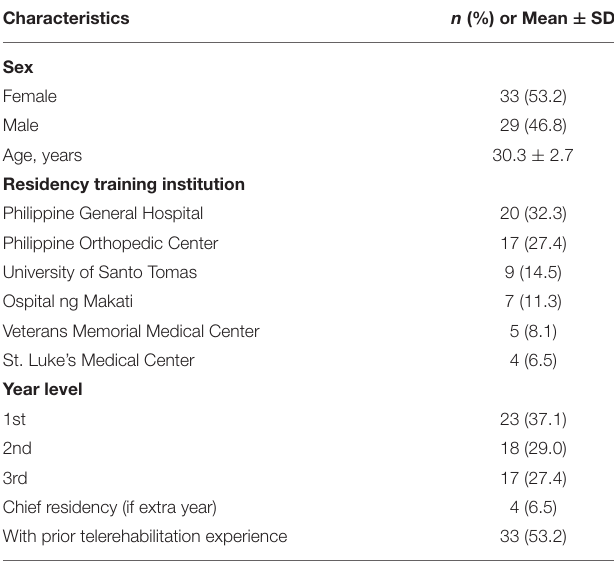
TABLE 1 | Demographic profile of the respondents ( N = 62).